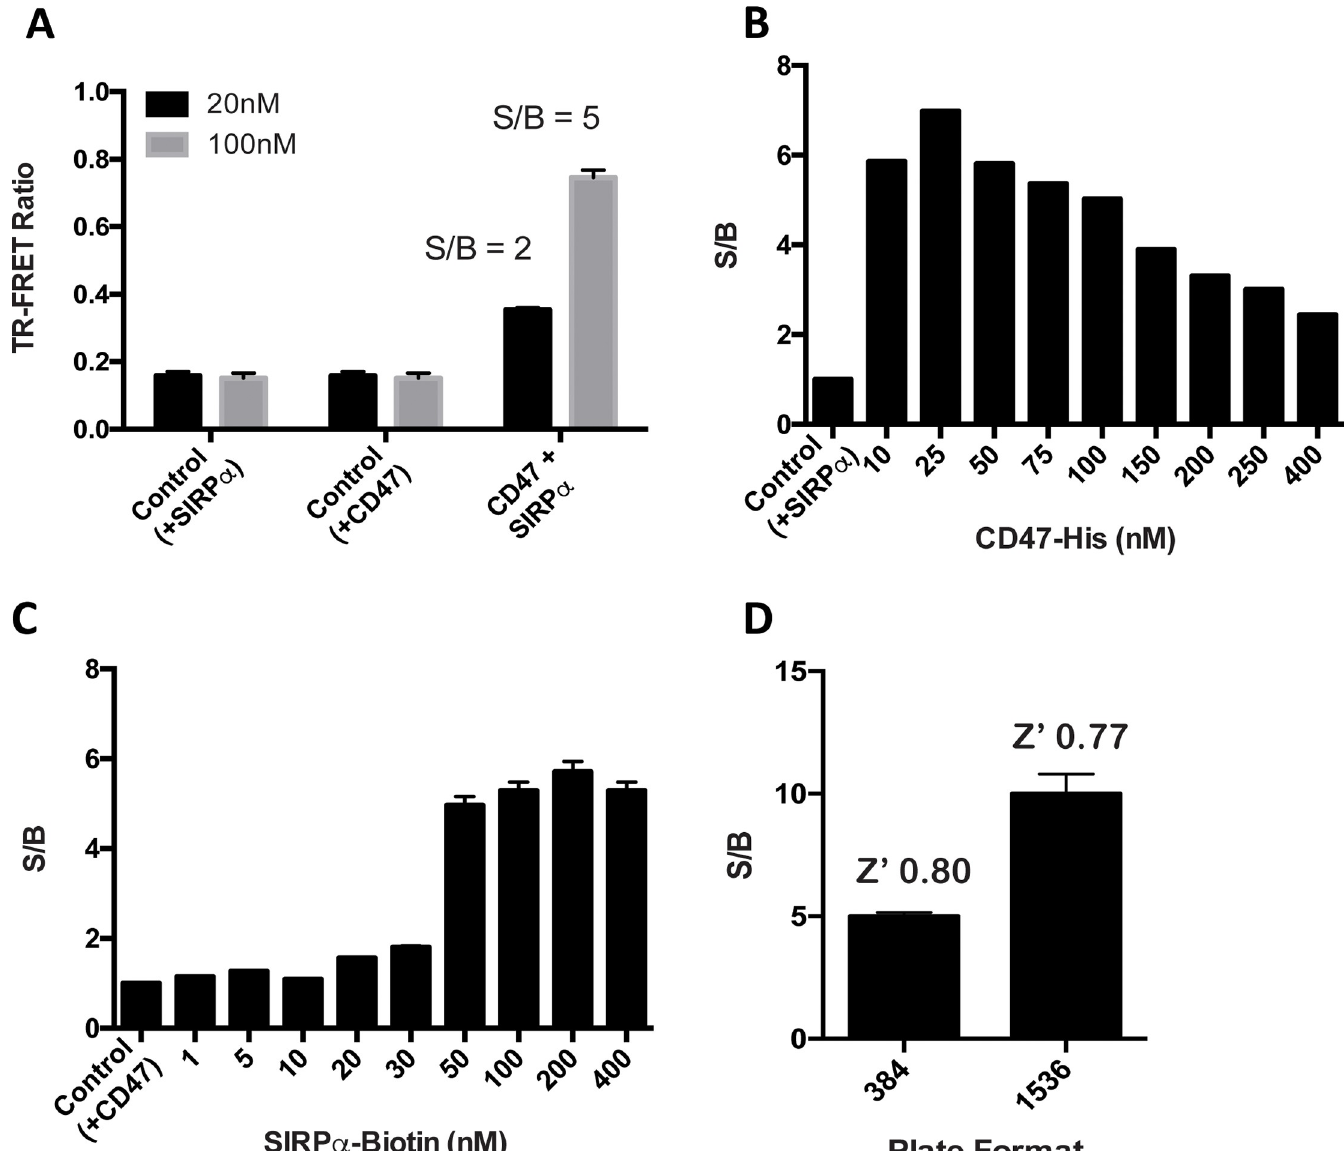
Fig 4. Optimization of CisBio TR-FRET assay. (A) Initial assay feasibility performed in 384-well plate format using CisBio TR-FRET reagents. CD47 and SIRP α were tested at 2 concentrations (20 nM and 100 nM), and the FRET ratio of the complete reaction was compared to controls lacking either CD47 or SIRP α to calculate the S/B (n = 16). (B) CD47 or (C) SIRP α concentrations were titrated while the other was fixed as indicated in (A) in 384-well plates to find their optimal assay concentrations as judged by S/B (n = 4). (D) Assay performance in 384-well or 1536-well formats compared using optimized concentrations derived from panels B and C. Assay Z’ indicated for each plate type (n = 32).